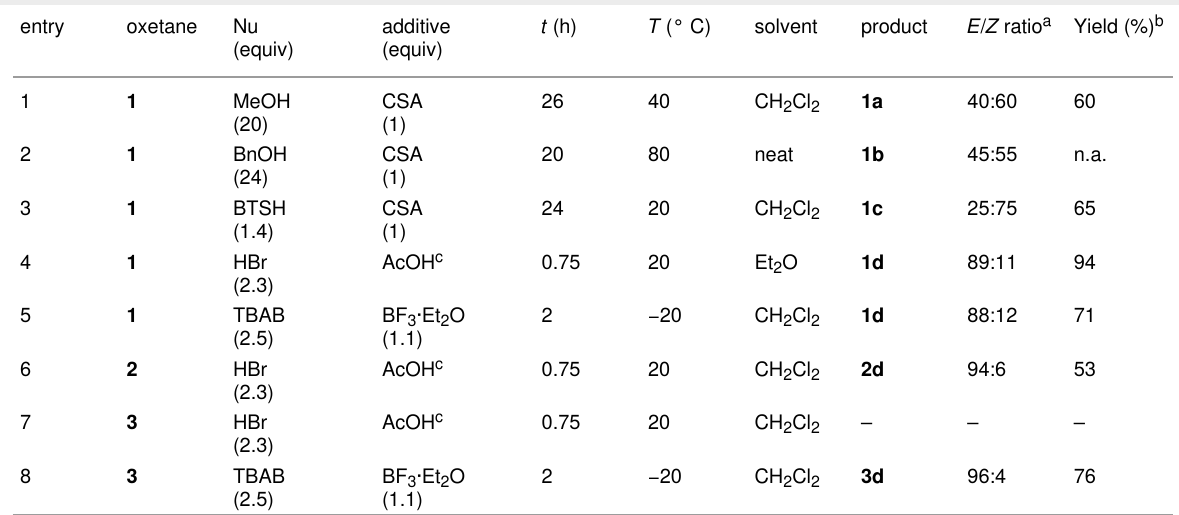
Table 1: Oxetane opening by various